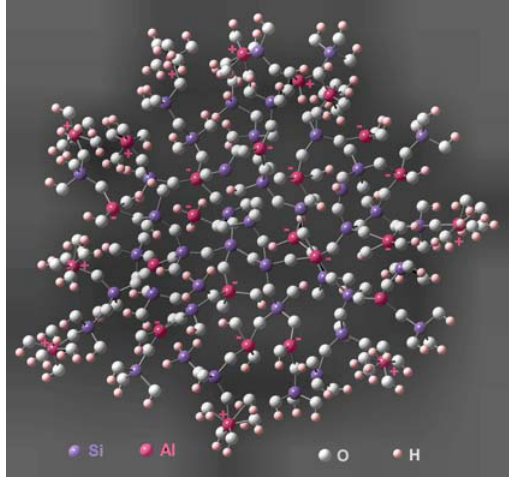
Figure 5. Chemical bond system of aluminosilicate aerogel with fractal structure. All geometry optimizations were performed using Gauss View. The size of elementary unit controlled by Gauss View is 3 nm